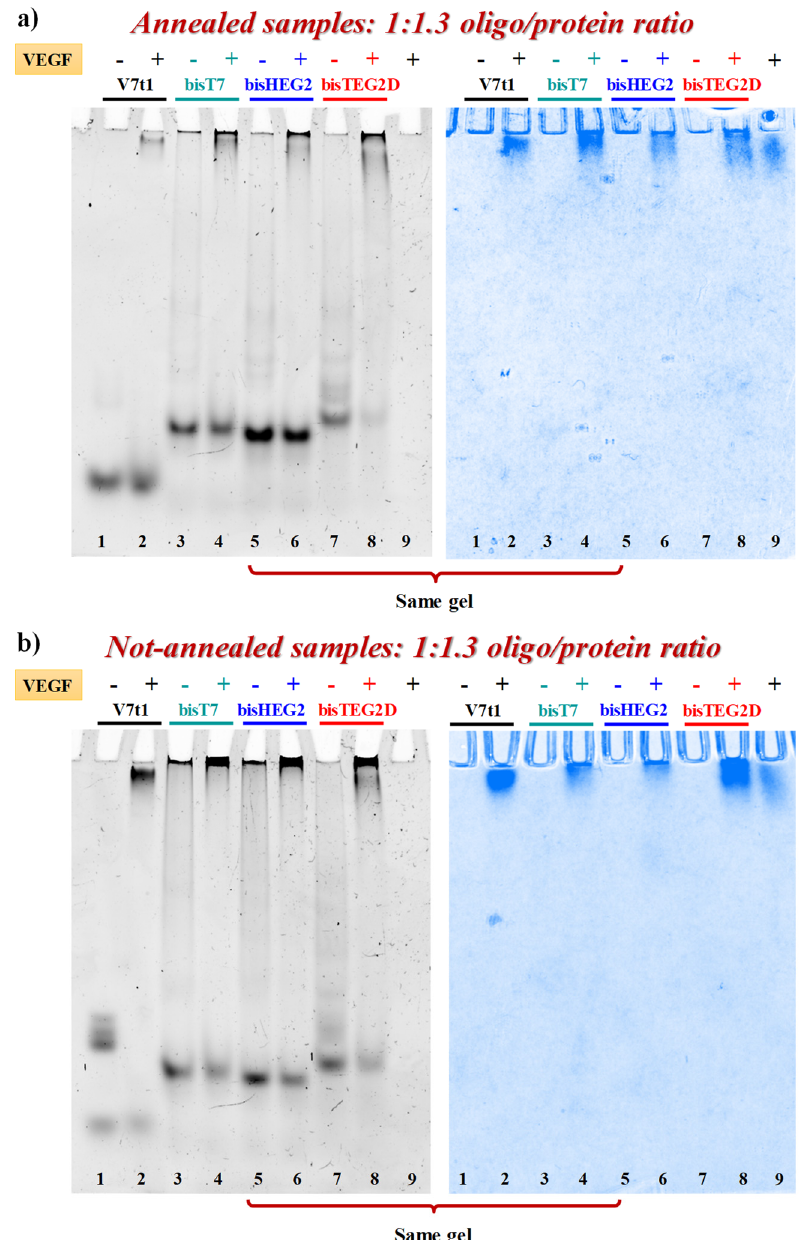
Figure 6. Native 7% electrophoretic mobility shift assay (EMSA) of A. ( a ) and N.A. ( b ) V7t1 and covalent V7t1 dimers incubated in the presence (+) or absence ( − ) of VEGF 165 . GelGreen- and Coomassie-stained gels (left and right, respectively). 30 pmol of each aptamer were incubated with 40 pmol of the protein in a final volume of 9 μ L in the selected HEPES/Na + buffer, thus obtaining a final 1:1.3 oligo/protein ratio. Gels were run at constant 45 V for 2.3 h at r.t. in TAE 1X buffer.